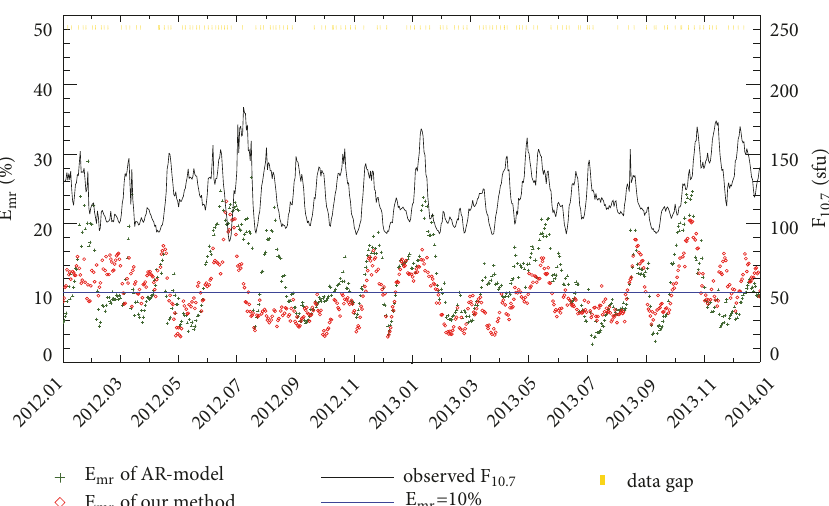
Figure 9: E mr derived by the 54th-order AR-model (green plus signs) and our method (red diamonds) during 2012-2013. The solid black line represents observed F 10.7 , and the solid blue line represents E mr equal to 10%. The short yellow vertical line at the top represents missing data due to the incomplete EUV images.